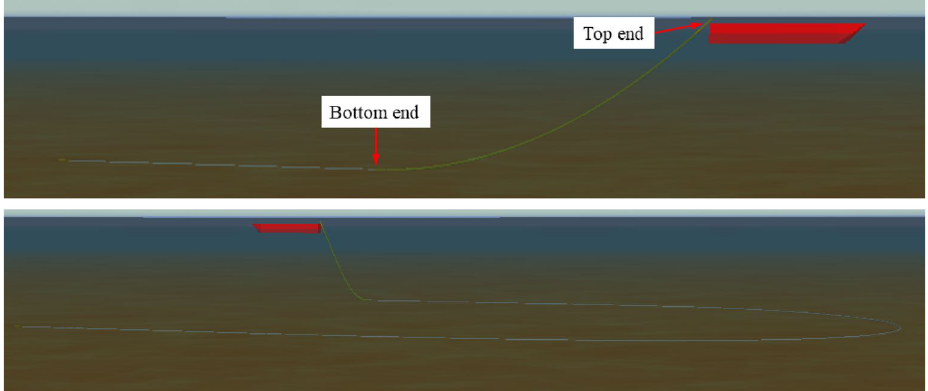
Figure 3. Model of marine cable with variable length during turning process.